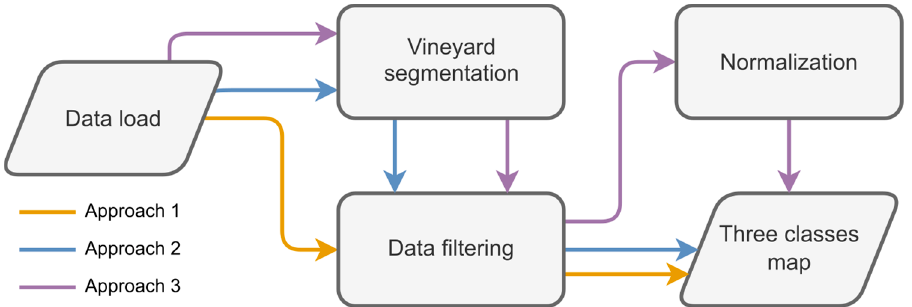
Figure 4. Approaches tested to produce vigour maps using three vigour classes.